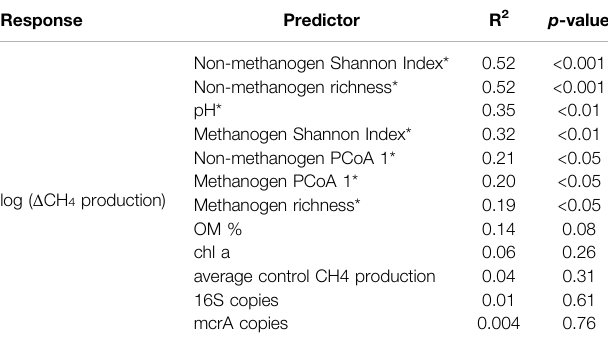
TABLE 2 | Summary statistics of linear regressions between the log-transformed difference in net CH 4 production between organic matter additions ( Δ CH 4 production) and environmental and microbial